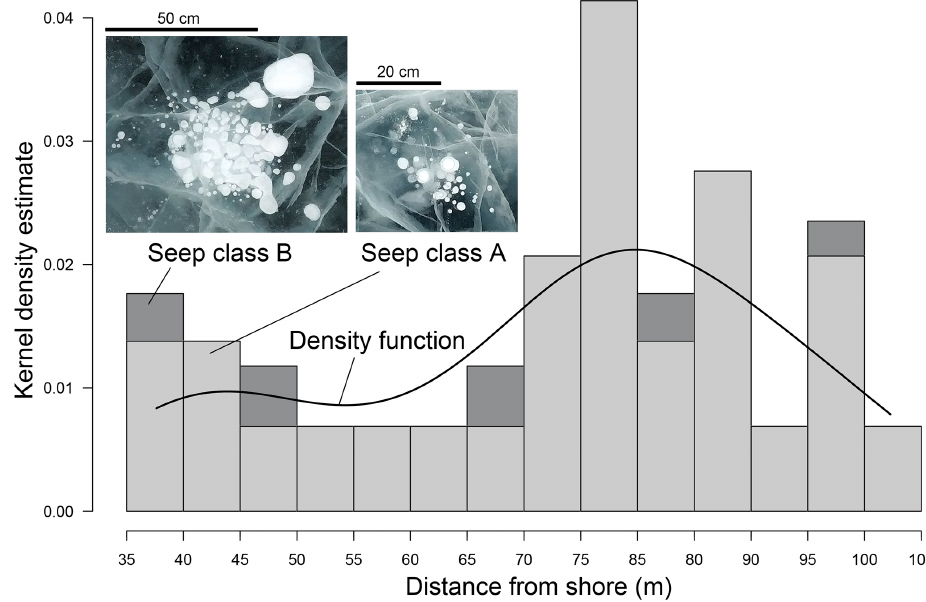
Figure 3. Distribution of CH 4 seeps of class A and B (Walter Anthony and Anthony, 2013) in Goltsovoye Lake (LK) perpendicular to the northwestern shore in a snow-cleared area of 70 × 1 . 4m. Bars represent the frequency of seeps A and B given as probability. The black line shows the kernel density function (Gaussian kernel performed on distances to shore; width is 34 data points). Table 2. The mean ± SD values and ranges (in parentheses) of measured parameters for all ice core samples for each transect are shown. Parameter Transect Tiksi Bay (BY) Polar Fox Lagoon (LG) Goltsovoye Lake (LK) Salinity 0.64 ± 0 .